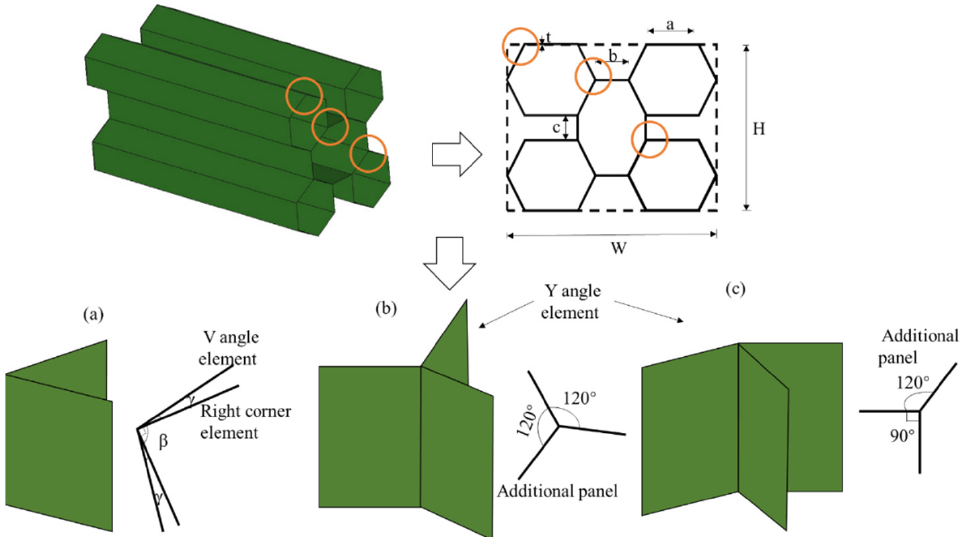
Figure 2. Three-panel element and simplification: ( a ) V angle element and right corner element; ( b ) Y-I unit element; ( c ) V-shaped unit element.